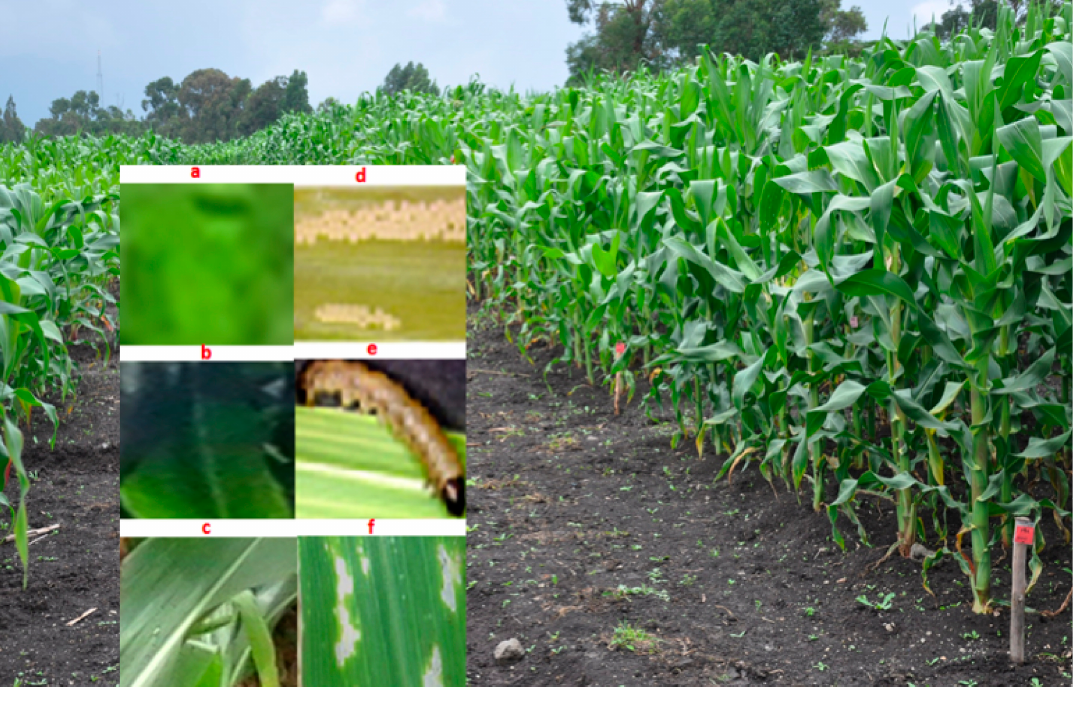
Figure 4. Example images collected using the ODK of a trial plot, ( a – c ) close images of leaves, ( d ) leaf of maize with insect egg, ( e ) insect larvae, and ( f ) signs of damage to the maize by disease.